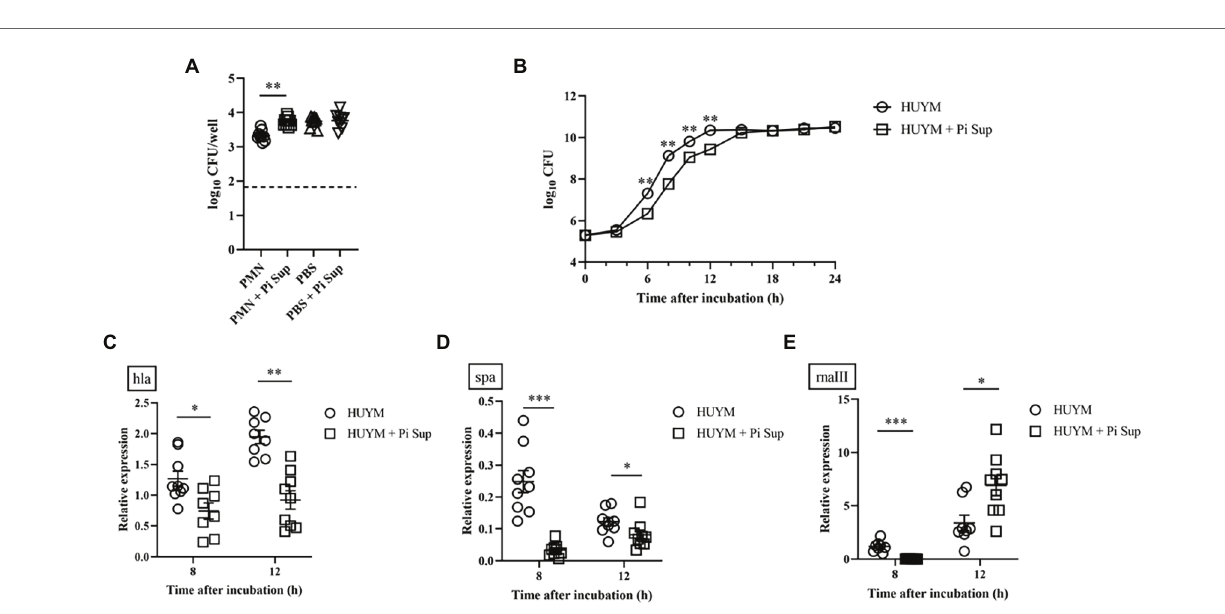
FIGURE 3 | (A) Effect of Pi Sup on phagocytosis of human PMNs against the HUYM MRSA strain in vitro . Bars represent mean bacterial counts, the broken horizontal line represents the lower limit of detection (1.7 log10 CFU/well). Data are representative of three replicates from three independent experiments. (B) Effect of Pi Sup on HUYM growth in vitro . O , HUYM without Pi Sup; ◽ , HUYM with Pi Sup. Data represent the mean ± SEM of six replicates. Similar results were obtained from two independent experiments. Effect of Pi Sup on (C) hla, (D) spa, and (E) rnaIII mRNA expression in vitro . Bars represent the mean relative mRNA expression. Data are representative of three replicates from three independent experiments. * p < 0.05; ** p < 0.005; and *** p < 0.001.